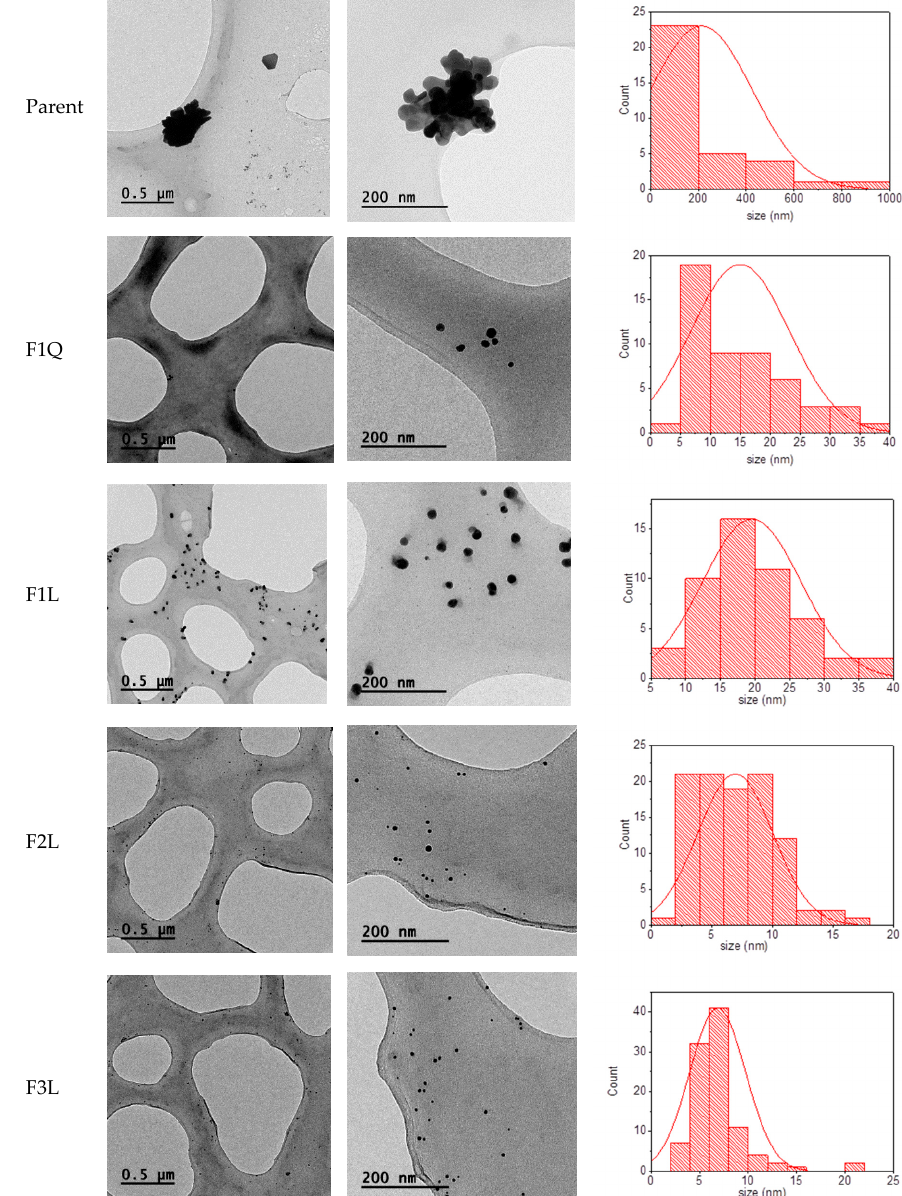
Figure 3. Transmission electron microscopy (TEM) micrographs and size histograms based on TEM images.